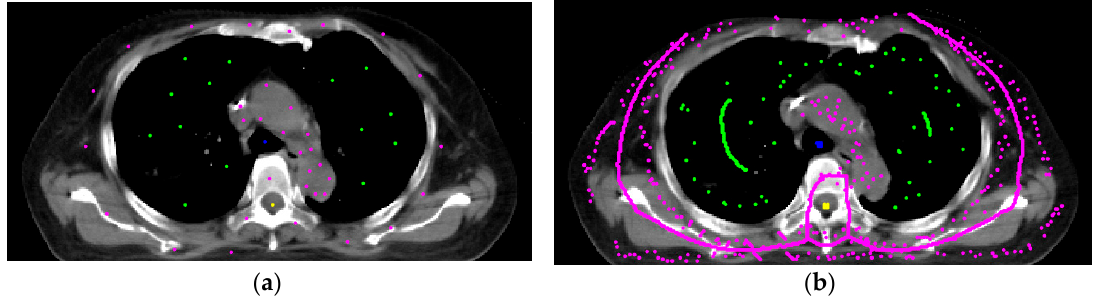
Figure 4. The seed generation and vanishing results. ( a ) The initial settings for seeds of different categories. ( b ) The automatic seed generation and vanishing on the next slice (superior direction).